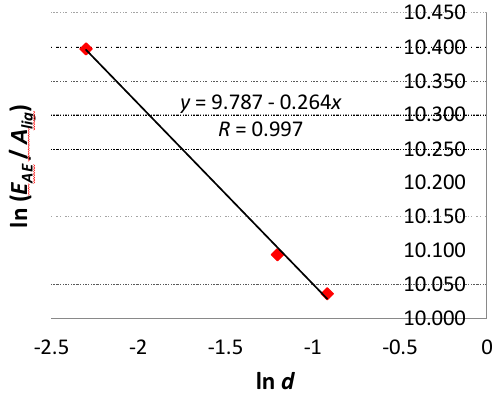
Figure 6. AE energy per unit area vs. beam depth diagram ( R is the Pearson correlation